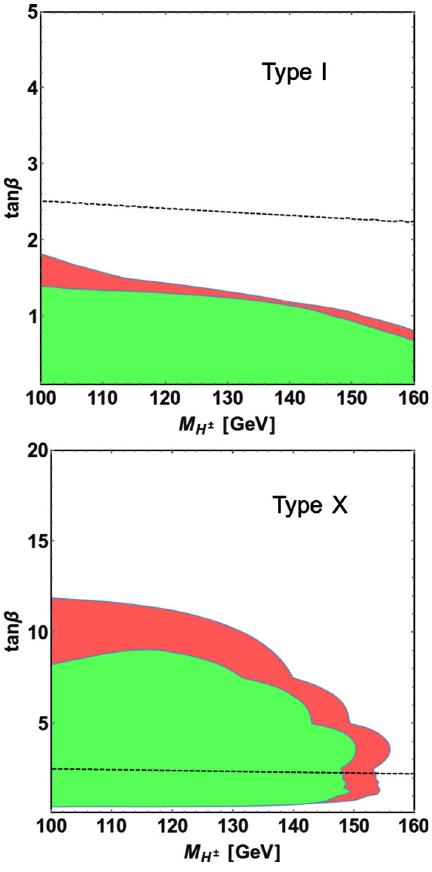
Fig. 5 Exclusion region in Type I and Type X from the upper limits on σ H ± BR ( H ± → τ ± ν) CMS 13 TeV observations are shown in red color. The green color shows the exclusion region from the upper limits on BR ( t → H + b ) BR( H ± → τ ± ν ) CMS 8 TeV observations. The region below the black dashed line is excluded by the BR( B → X s γ ) constraint. Here the mass difference M H ± − M A = 85 GeV for M H ± ∈ [ 100 , 160 ] GeV and M ∼ M H is considered. The exclusion region H ± is less compared to Fig. 3 where the masses of H ± , H and A are nearly the